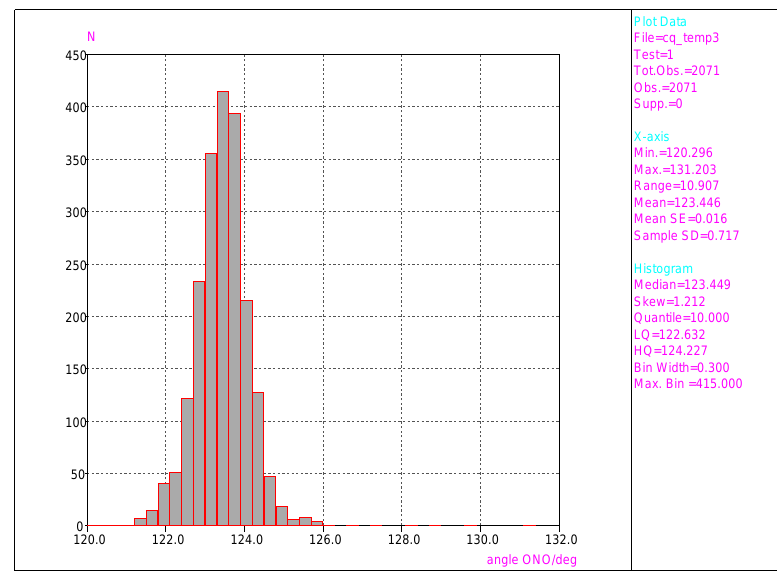
Figure 1. Distribution of ONO angles for para -substituted nitrobenzene derivatives.